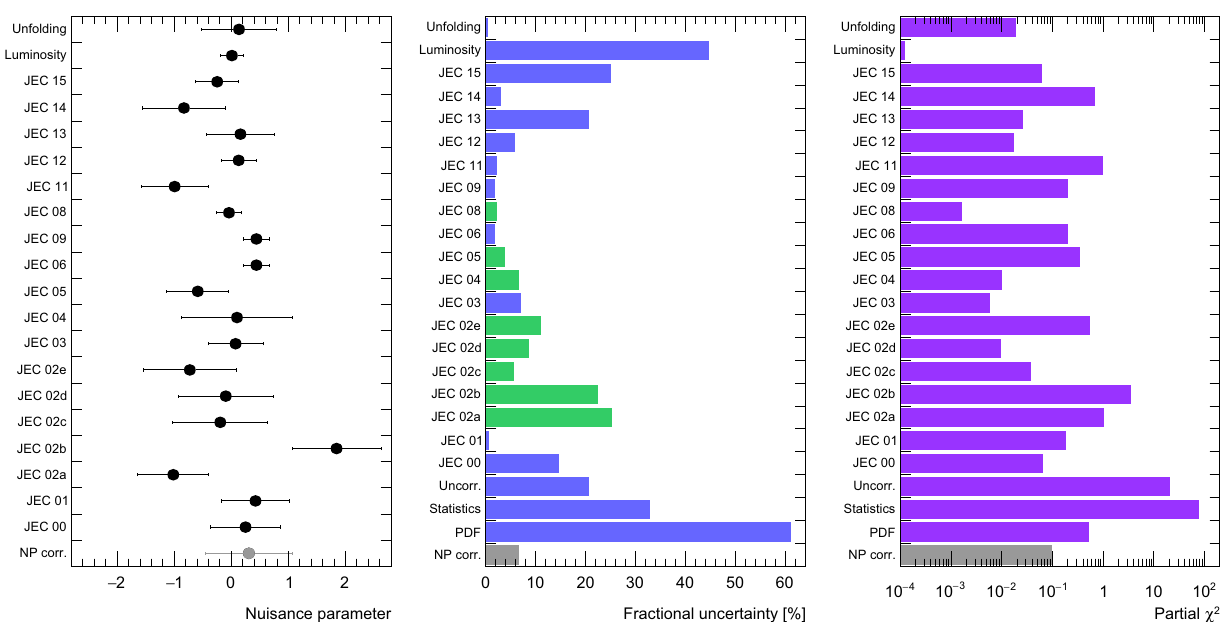
Fig. 10 Left: nuisance parameters of the systematic uncertainties in the α s ( m Z ) fit to CMS inclusive jet cross section data. Details on these uncertainties are found in Refs. [96,104]. The gray value(s) are not included in the χ 2 computation but are propagated separately. Middle: size of the individual uncertainty components to the total uncertainty of